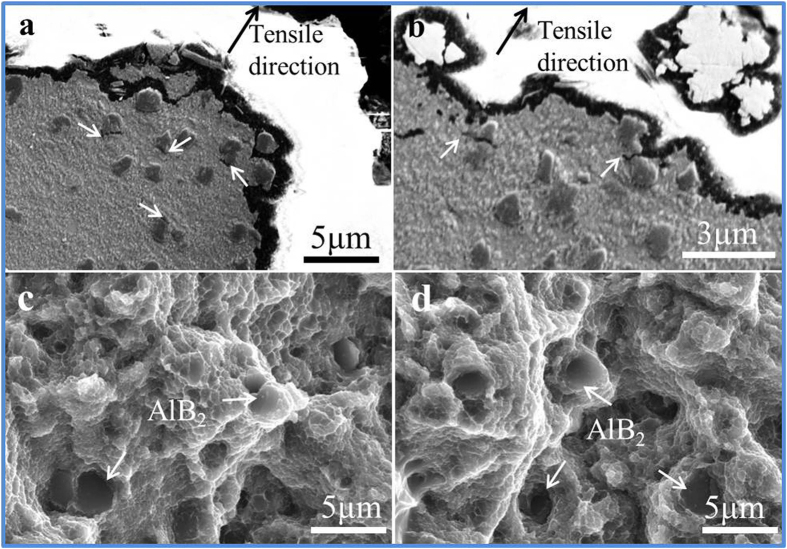
The fracture characteristic of the AlNp/Al composites at RT.(a,b) Cross-sectional observation of the 16.4% sample fracture reflecting the crack traces. (c,d) The fracture surface of the 4.1% (c) and 16.4% (d) composites shows the crack mode is particle crack. The exposed AlB2-terraces is the evidence.